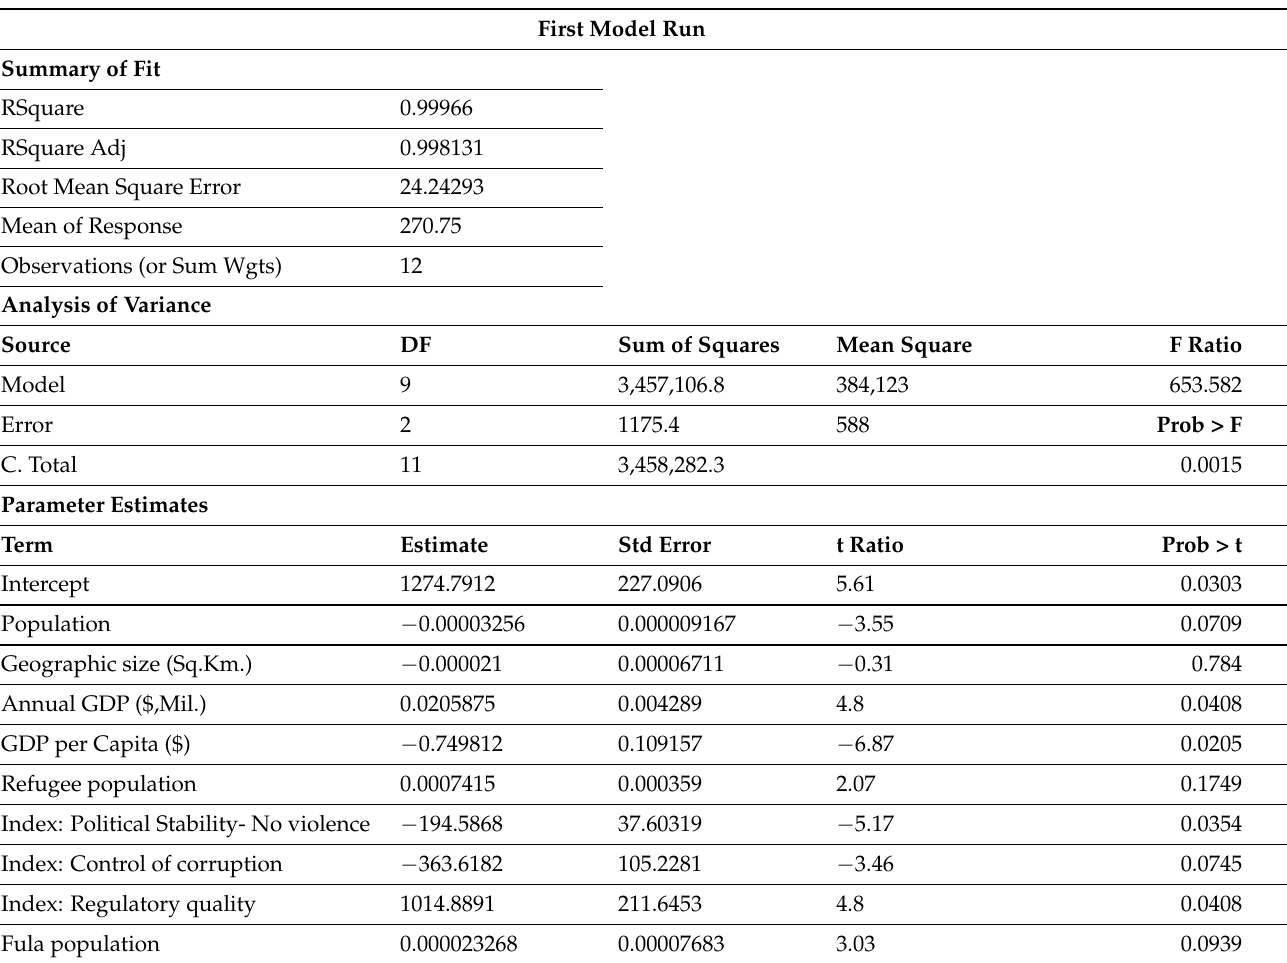
Table 7. Fitting the multiple regression model with a backward selection of covariates—the first model